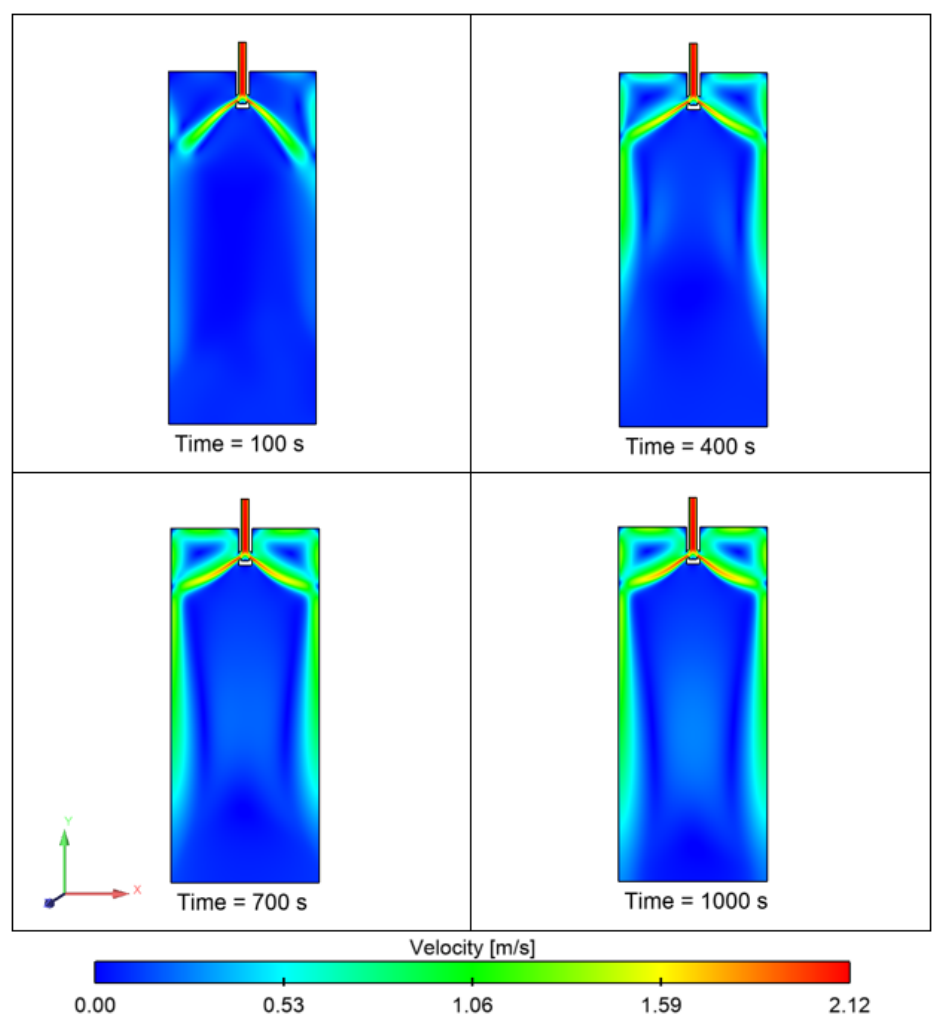
Figure 12. Velocity contour of the mold domain (initial melt temperature: 1853 K).